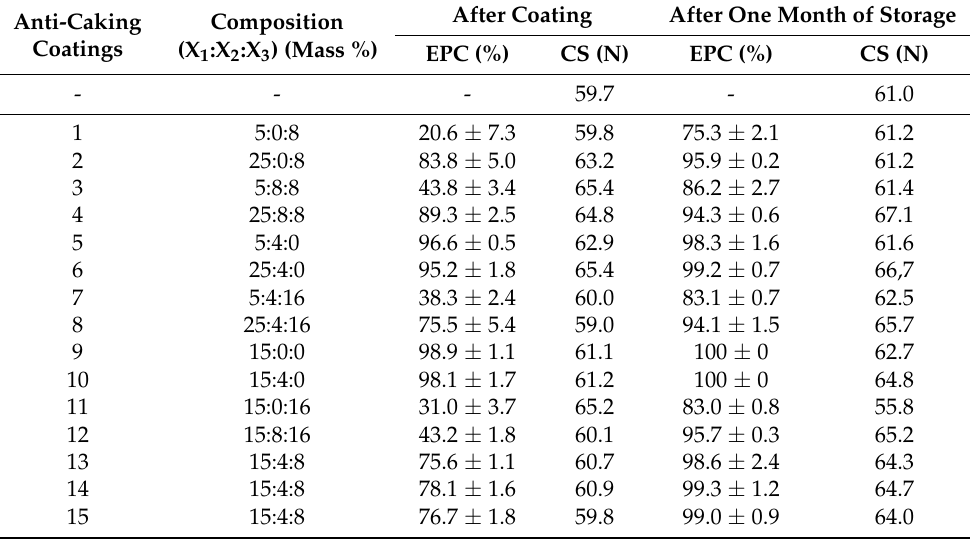
Table 6. The effectiveness of anti-caking agents and the crushing strength of granules of AN fertilizers coated with the developed anti-caking coatings and of raw (uncoated) fertilizer. Anti-Caking